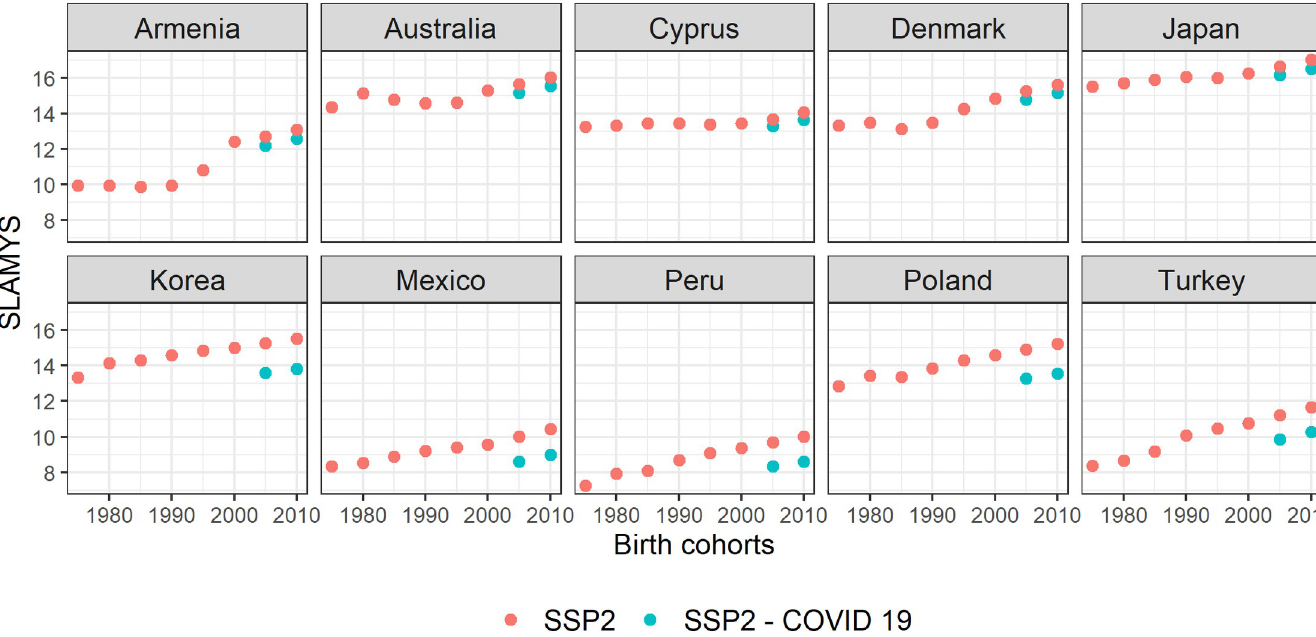
PLOS ONE | https://doi.org/10.1371/journal.pone.0277113 November23,